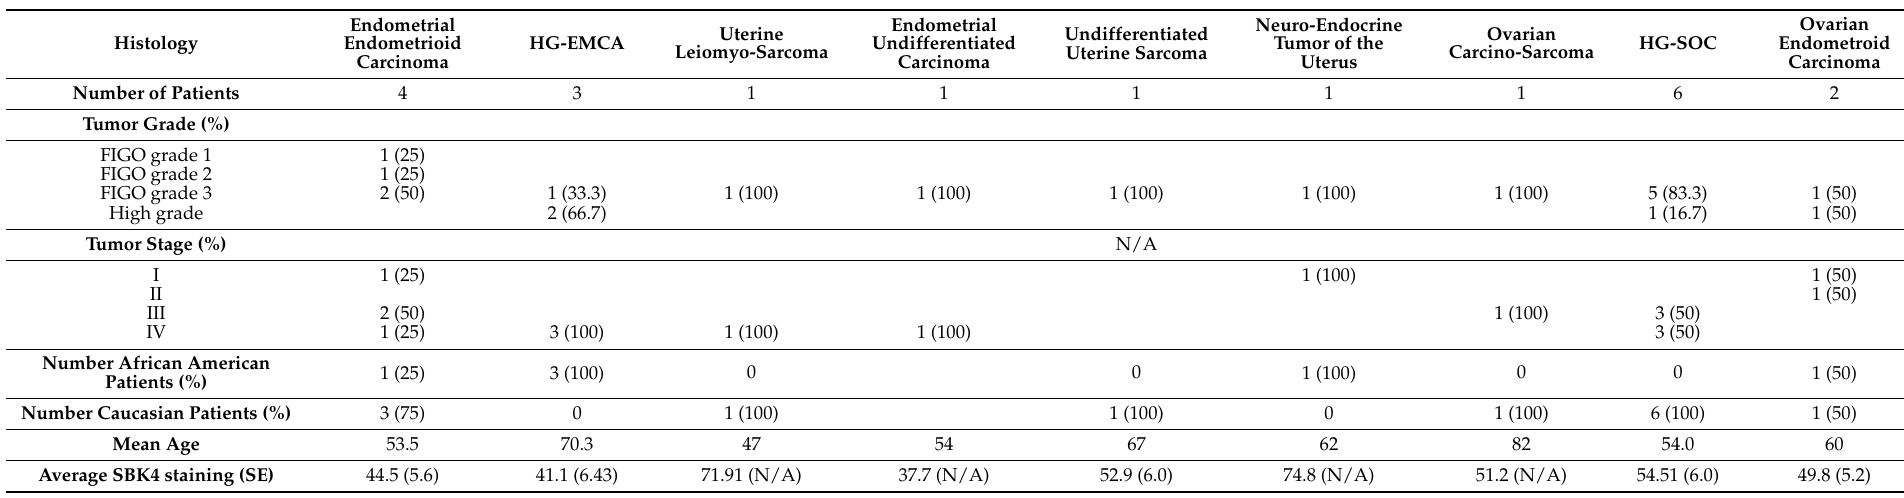
Table 1. Clinicopathological characteristics of patients from whom PDXs are derived.